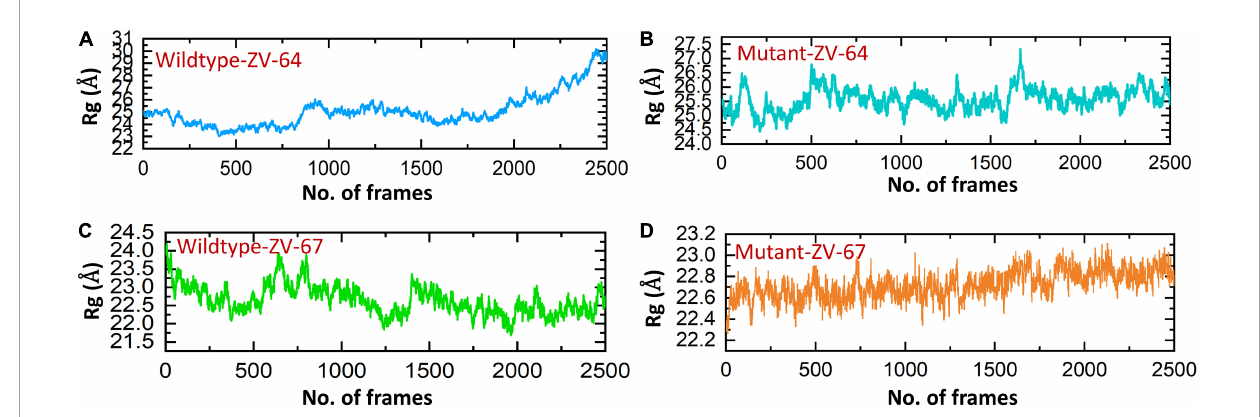
FIGURE6 Calculation of Rg for all complexes. (A) Rg value for the wild-type DIII-ZV-64 complex, (B) Rg value for the mutant DIII-ZV-64 complex, (C) Rg value for the wild-type DIII-ZV-67 complex, and (D) Rg value for the mutant DIII-ZV-67 complex.